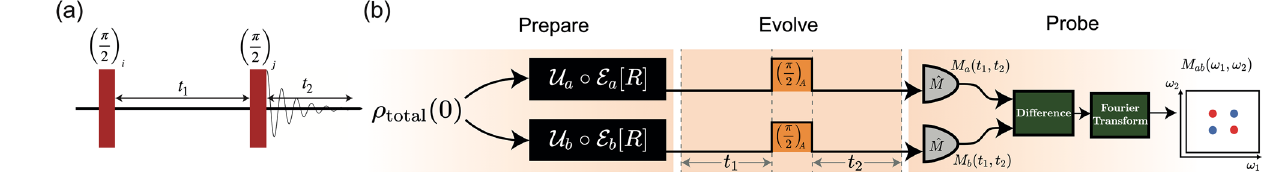
Figure 1. ( a ) A generic pulse sequence for two-dimensional spectroscopy. i and j denotes the direction of the rotation caused by the pulse. The most commonly used setting is i ( b ) Schematic of the Preparation Probe Spectroscopy (PrePSy). The first part is the preparation part where conditional measurement is performed. The second part is the evolve part which is a time delayed pulse and time delayed measurement. Finally difference of the measured signals is taken followed by a Fourier